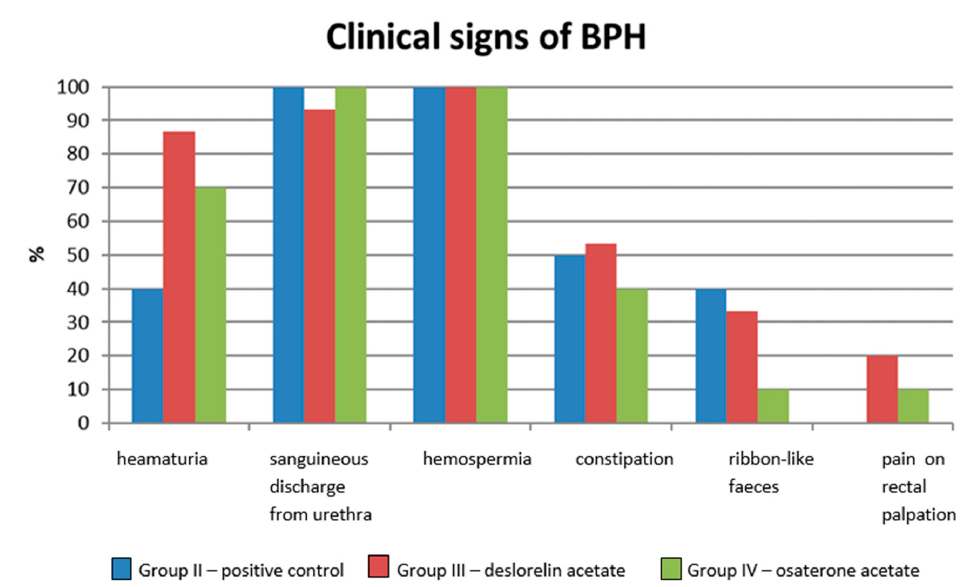
Figure 2. Clinical signs related to BPH in dogs included in Control Group II and Treated Groups III and IV, on Day 0 before any treatment.